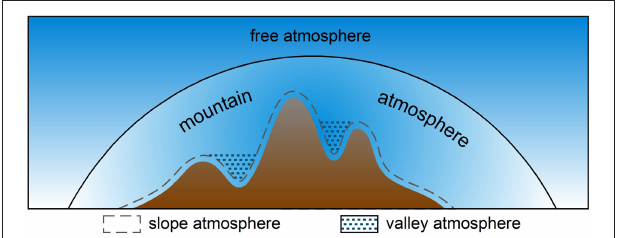
FIGURE 1 | Structure of the lower atmosphere over a mountain. The solid line indicates the boundary between the free atmosphere and the atmosphere influenced by the mountain. The dashed line indicates the top of the slope atmosphere, while the hatched pattern indicates the valley atmosphere (after Ekhart,